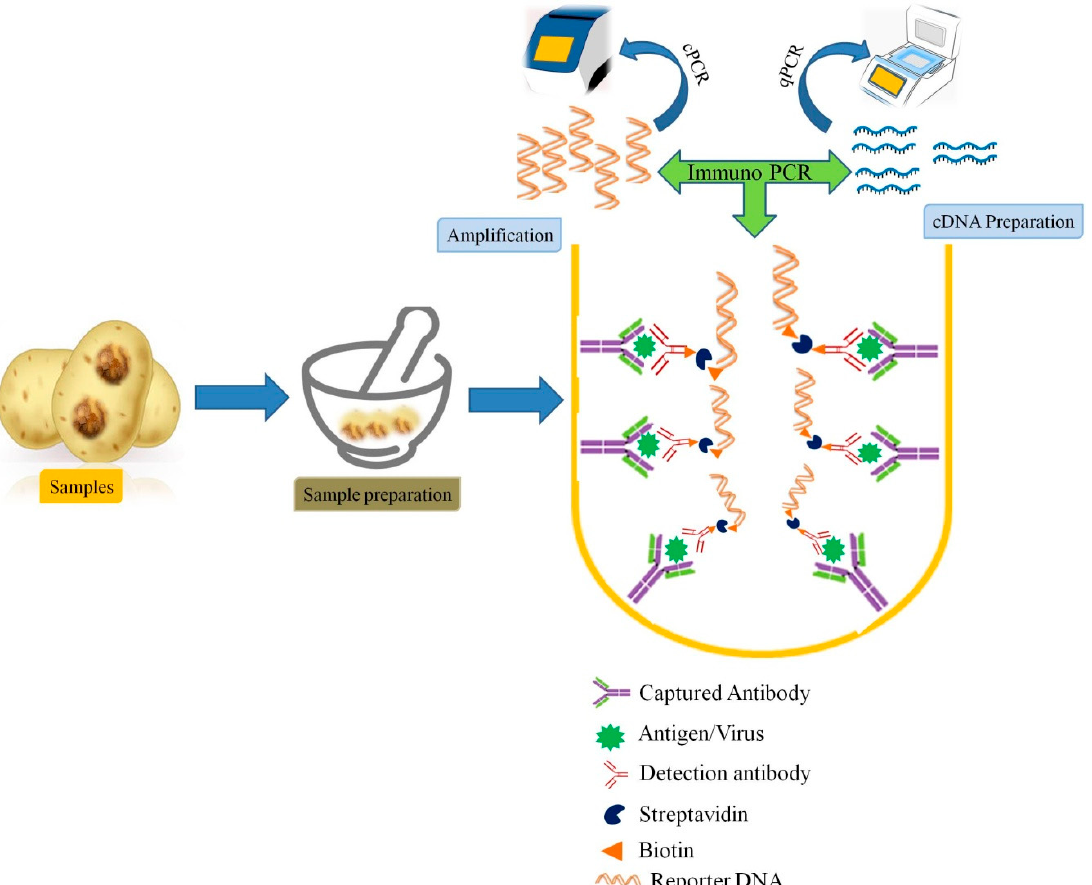
Figure 2. Schematic representation of Immunocapture PCR (IC-PCR) used in plant viral diagnosis.